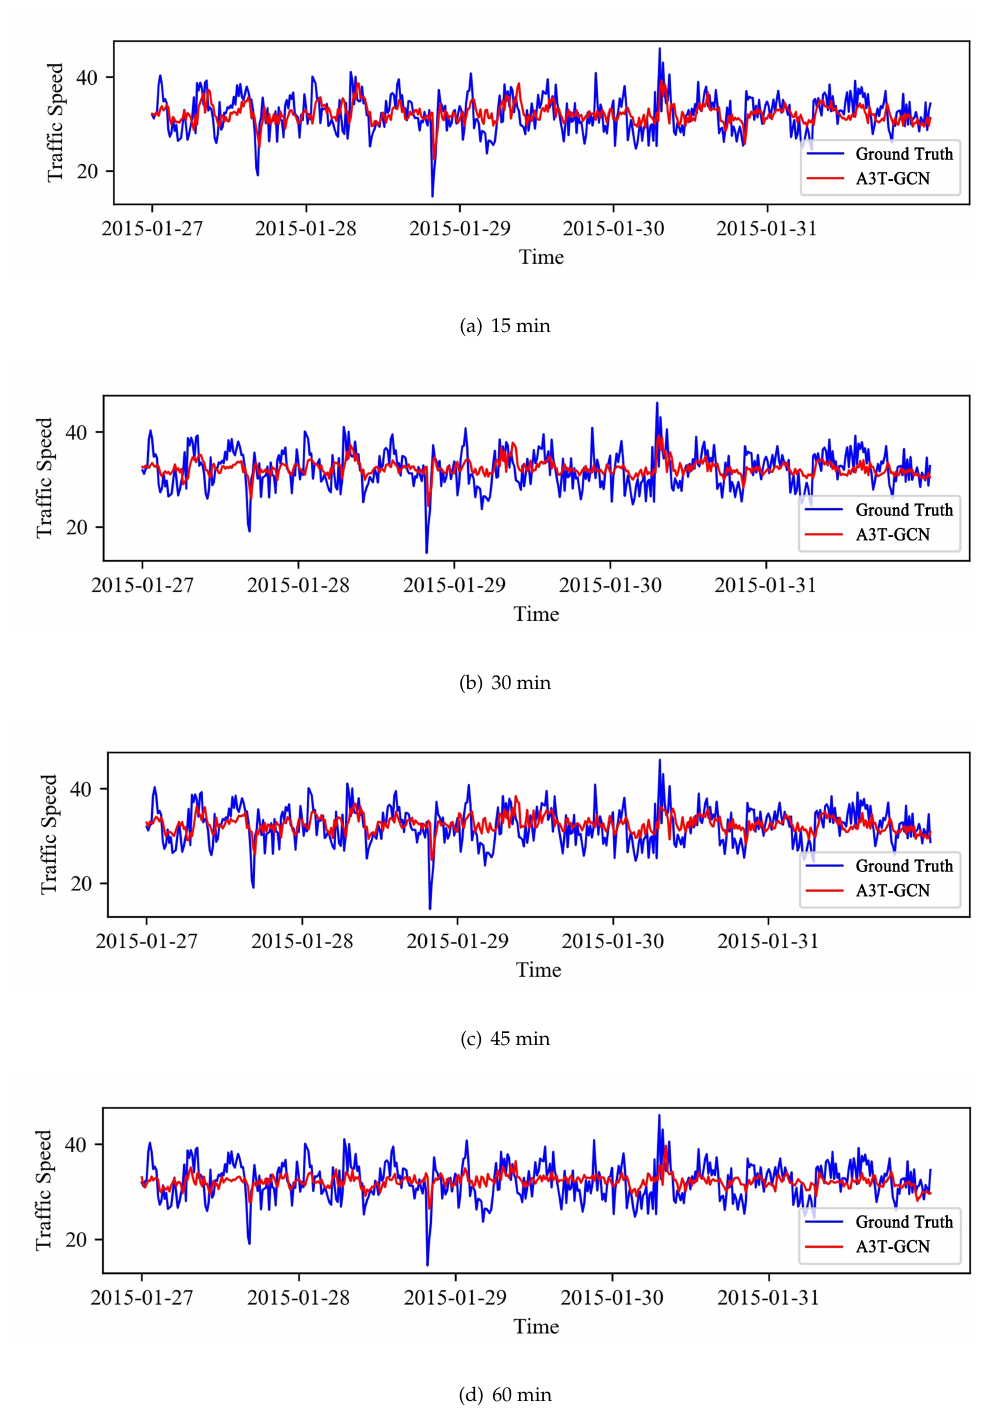
Figure 8. The visualization results for prediction horizon of 15, 30, 45, 60 min